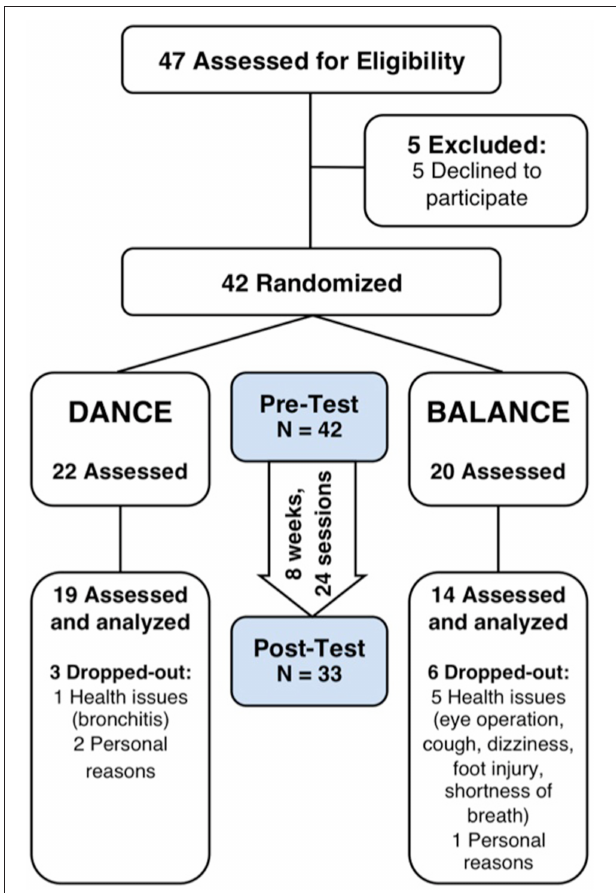
FIGURE 3 | Participants’ flow and trial design. Participants were randomly assigned to either DANCE or BALANCE and were trained over 8 weeks three times per week for 30 min. fNIRS prefrontal cortex activity during treadmill walking, cognitive performance, Short Physical Performance Battery, fear of falling, and depression were assessed at pre- and post-test. DANCE, video game dance training; BALANCE, balance and stretching